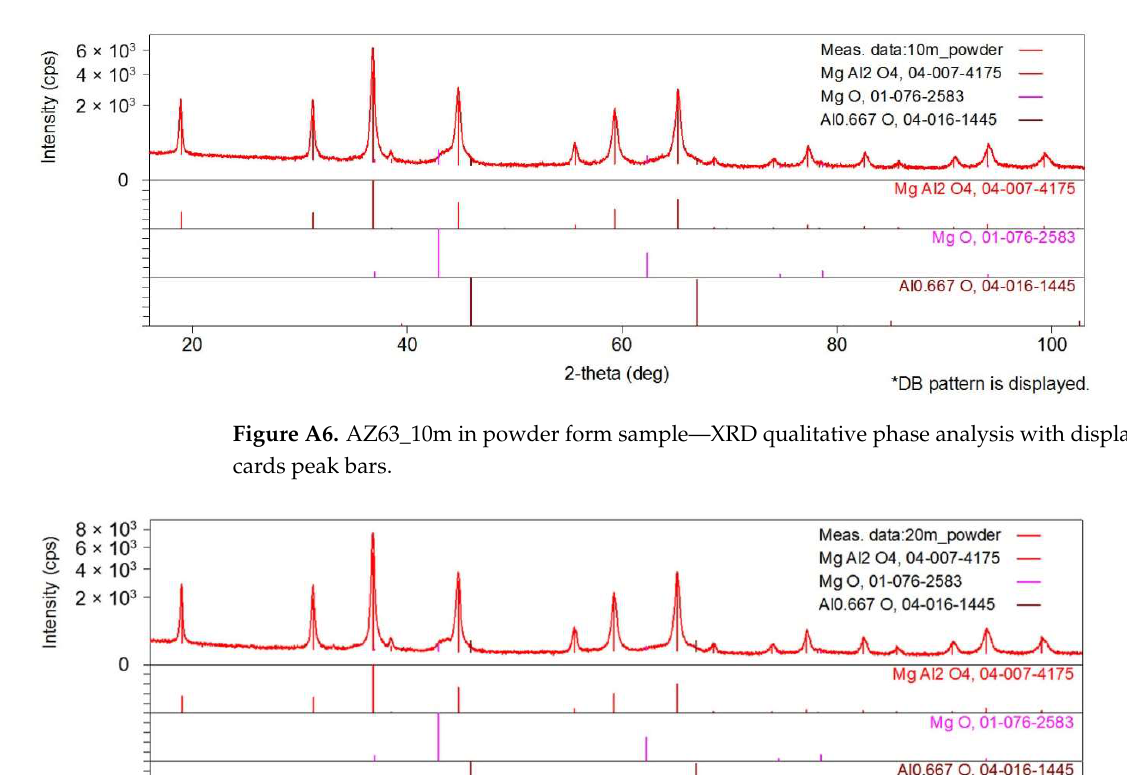
Figure A5. AZ63_5m in powder-form sample—XRD qualitative phase analysis with displayed PDF cards peak bars.